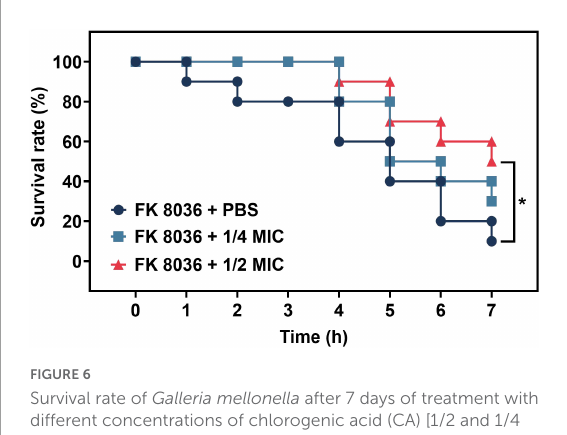
FIGURE6 Survival rate of Galleria mellonella after 7 days of treatment with different concentrations of chlorogenic acid (CA) [1/2 and 1/4 minimum inhibitory concentration (MIC)] against FK 8036. Kaplan–Meier analysis and log-rank test were performed to analyze the survival rate of G. mellonella